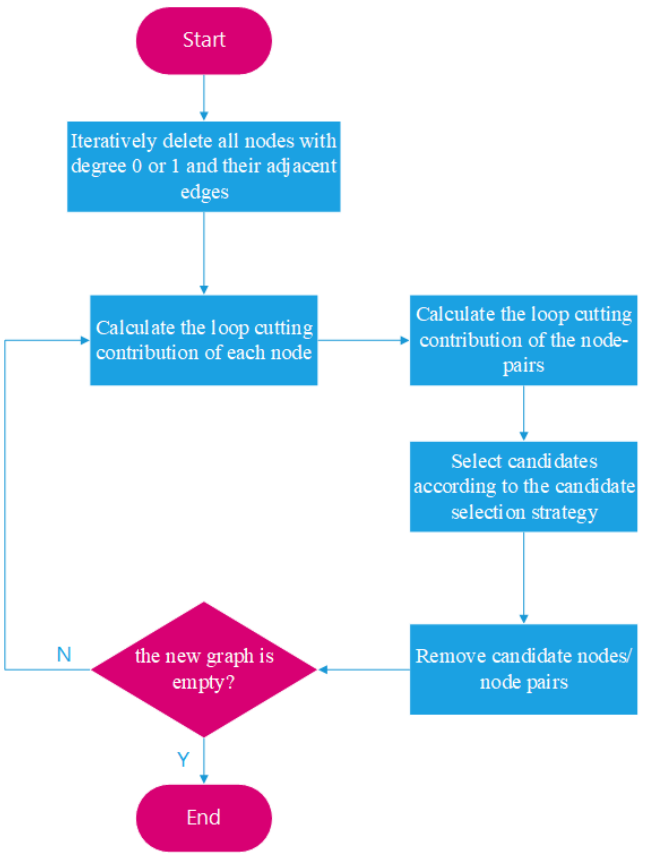
Figure 3. The algorithm flowchart of